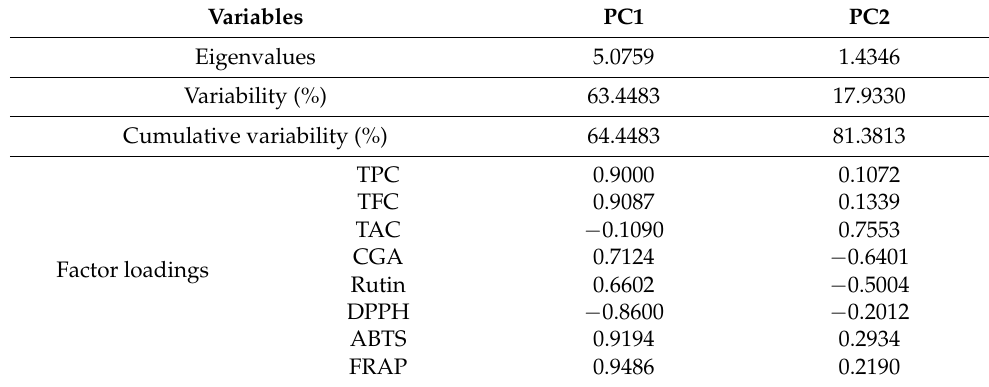
Table 5. Eigenvalues, variability, cumulative variability, and factor loadings associated with each principal